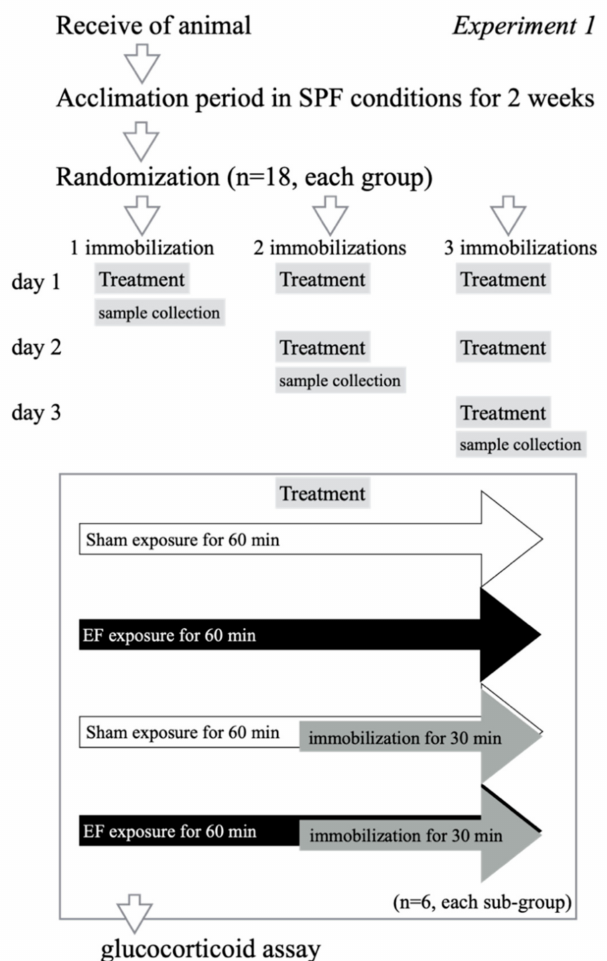
Figure 2. Experimental design to assess the effect of EF on plasma glucocorticoid levels in repeatedly immobilized mice, Experiment 1. To examine the effect of an EF on plasma glucocorticoids in repeatedly immobilized mice, 54 mice were divided into three groups according to the number of stress episodes (one, two, or three immobilizations; n = 18 mice each). Each group was further divided into three subgroups ( n = 6 per subgroup): a control (stress ( − )/EF ( − )), an immobilization-alone (stress (+)/EF ( − )), and a co-treatment group (stress (+)/EF (+)). Mice in the co-treatment group were exposed to the EF for 60 min and were immobilized during the second half (30 min) of the EF exposure period. In the control group, mice were handled in an identical manner, except that the EF condition was 0 V/m, and they were not